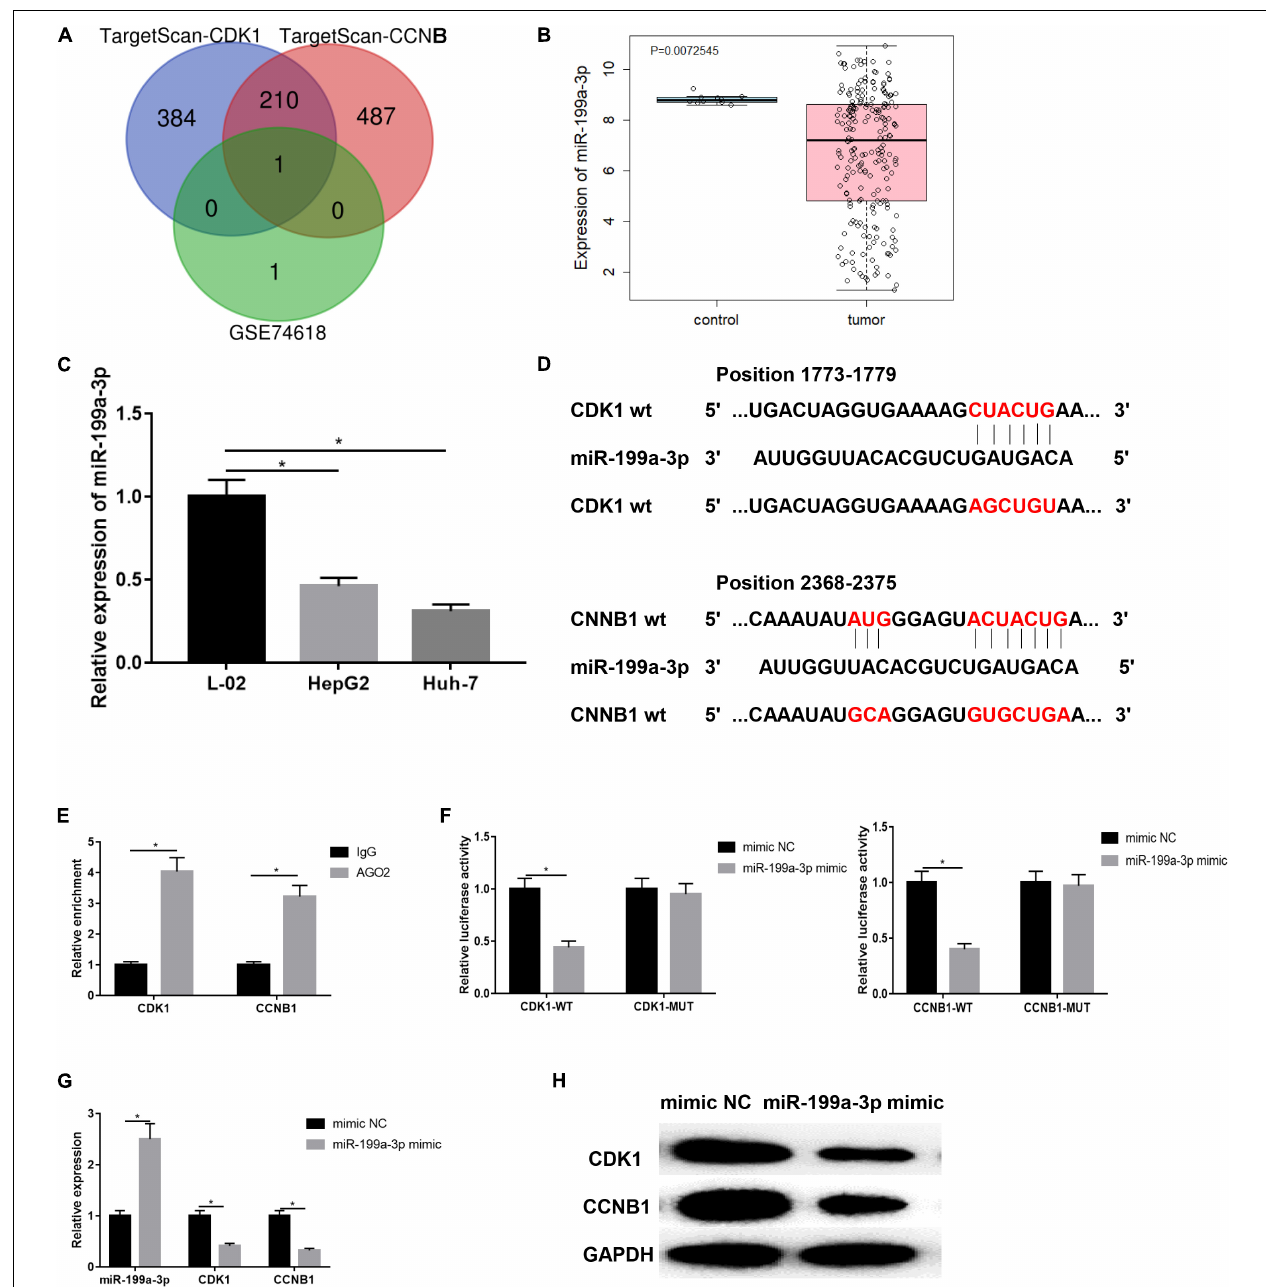
FIGURE 4 | miR-199a-3p targeted inhibited CDK1 and CCNB1 expression. (A) The miRNAs that regulate CDK1 and CCN1 were predicted by TargetScan and intersections with significantly down-regulated expression in GSE74618 of HCC; (B) miR-199a-3p expression in GSE74618 dataset, black represents the normal sample and red represents the tumor sample; (C) The expression of miR-199a-3p in L-02, HepG2 and Huh-7 cell lines was detected by qRT-PCR; (D) The binding sites of miR-199a-3p and CDK1 or CCNB1; (E) RIP assay was used to detect whether miR-199a-3p could bind with CDK1 and CCNB1; (F) Dual luciferase reporter gene assay was used to verify the targeted binding relationship between miR-199a-3p and CDK1/CCNB1; (G) The expressions of miR-199a-3p, CDK1 and CCNB1 in HepG2 cells were detected by qRT-PCR; (H) Protein expressions of CDK1 and CCNB1 in HepG2 cells was detected by WB. *represents P < 0.05.